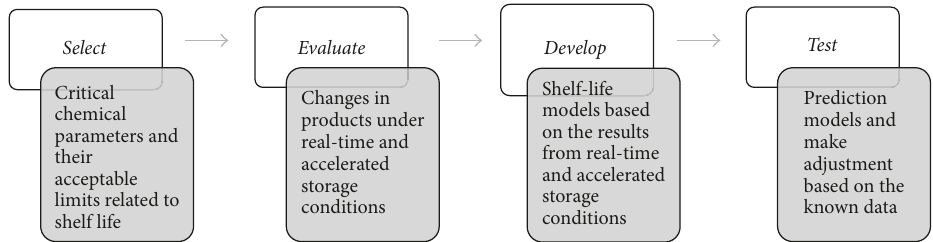
Figure 1: Shelf-life prediction model development